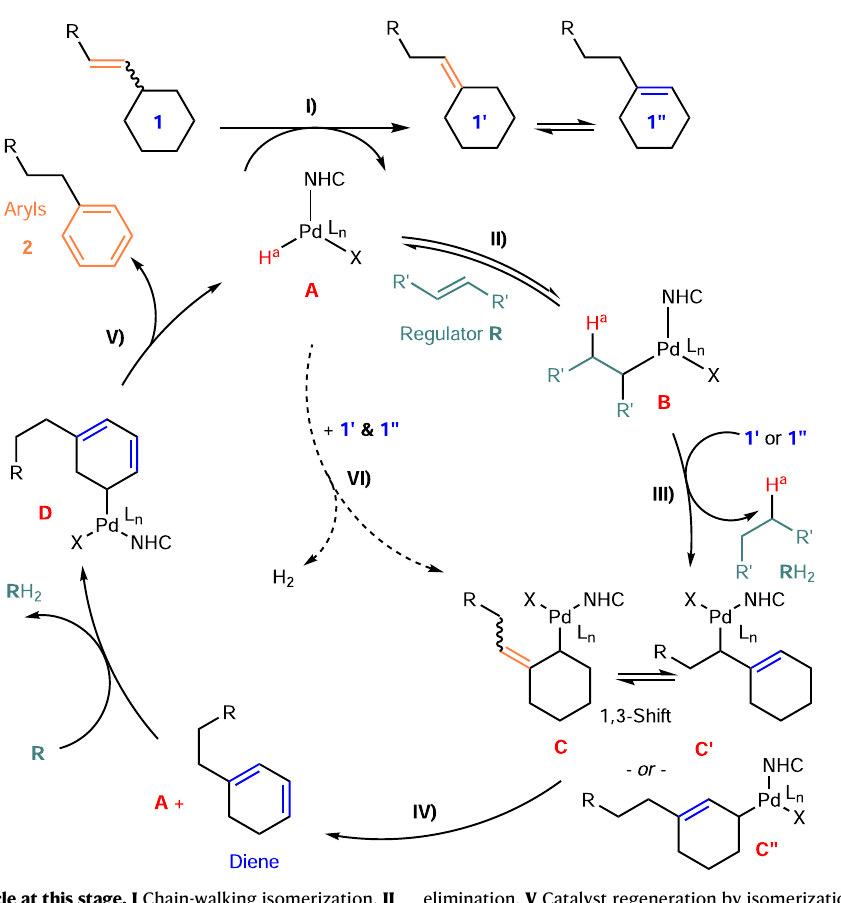
elimination. V Catalyst regeneration by isomerization and β -H elimination. VI H-transfer (minor).